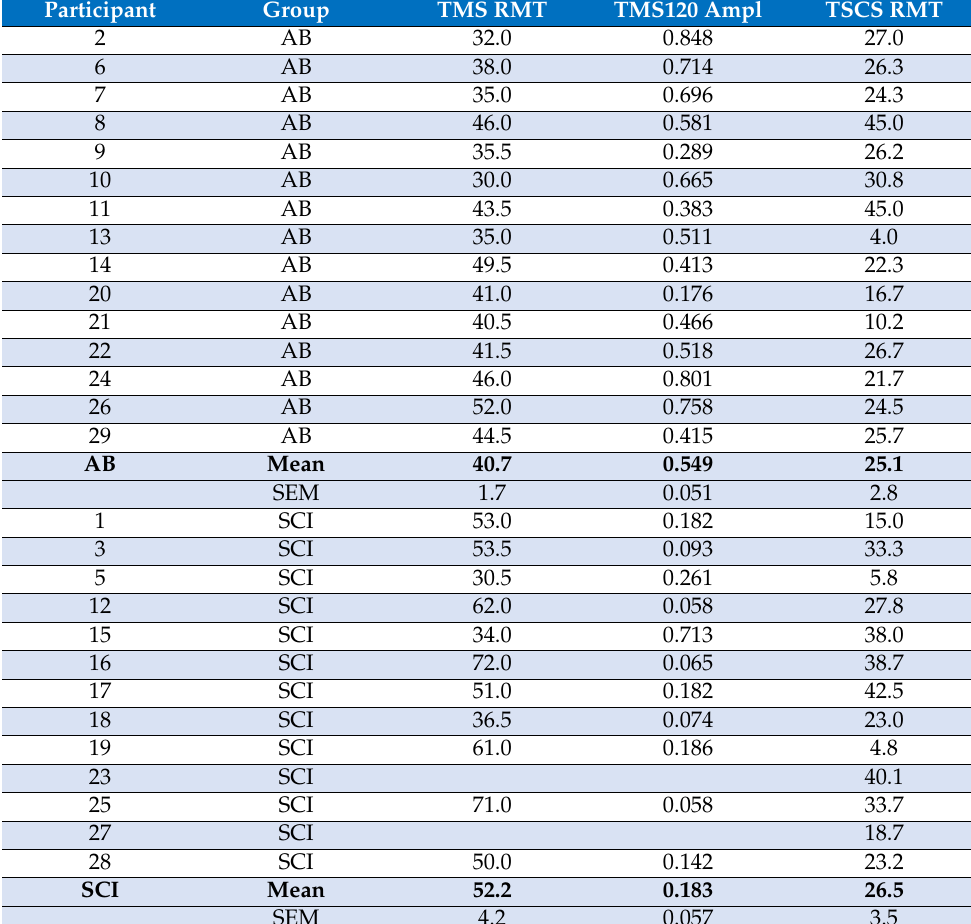
Table 3. Responses to unconditioned cortical and spinal